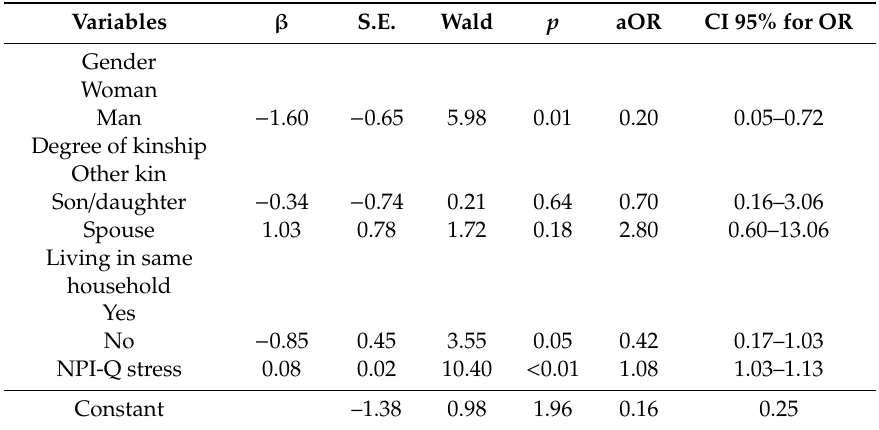
Table 5. Predictors of perceived health amongst early-stage family caregivers: Multivariate logistic